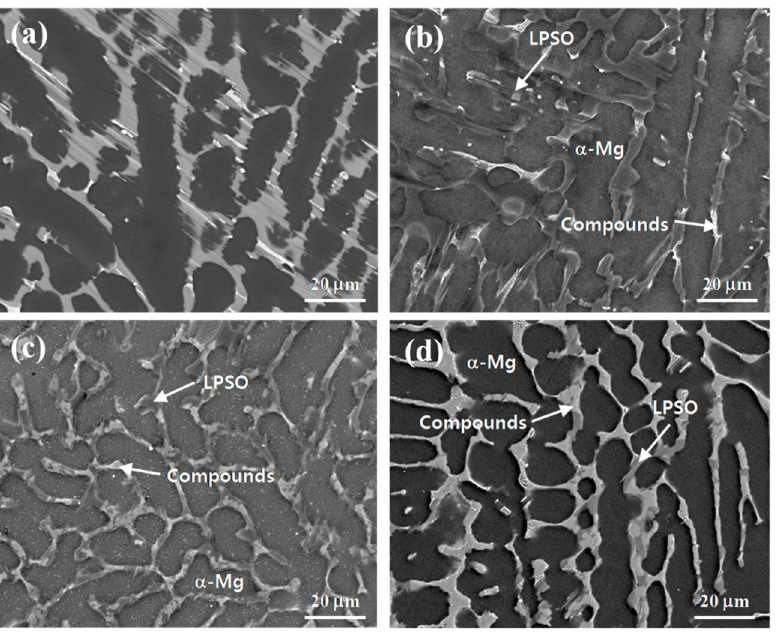
Figure 3. SEM microstructure of the as-cast alloys: ( a ) Mg 88.5 Zn 5 Y 6.5 ; ( b ) Mg 88.5 Zn 5 Y 5.0 Ce 1.5 ; ( c ) Mg 88.5 Zn 5 Y 3.5 Ce 3.0 ; ( d ) Mg 88.5 Zn 5 Y 2.0 Ce 4.5 .